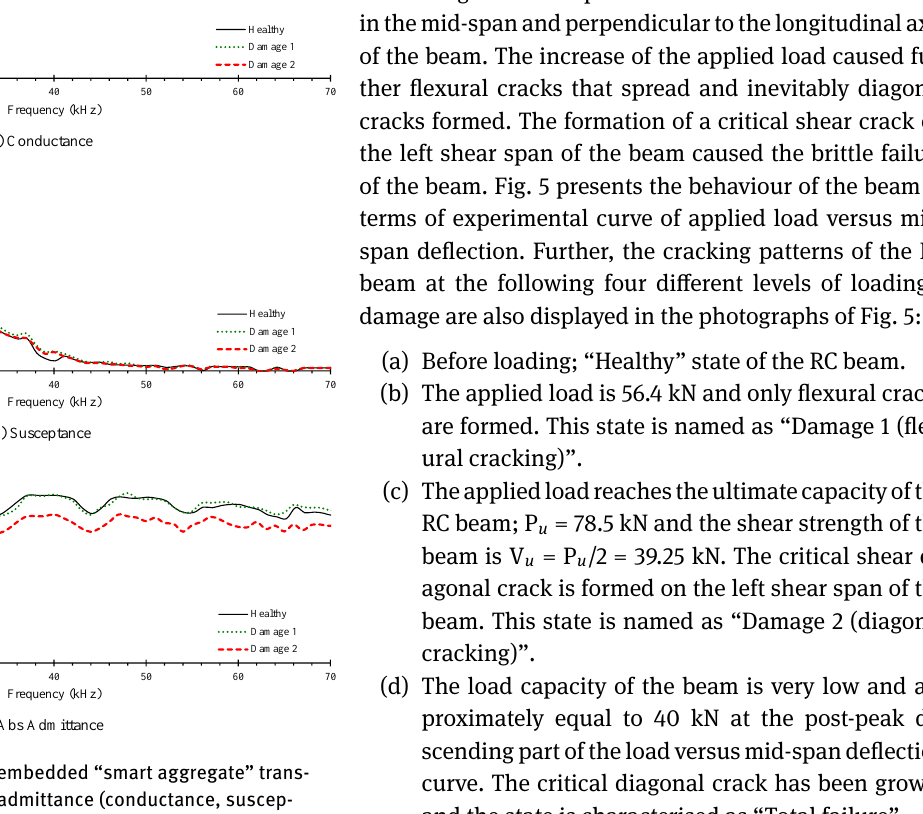
ing a pinned-end actuator and was measured by a load cell with accuracy equal to 0.05 kN. The net mid-span de- flections of the tested beam were recorded by three Linear VariableDifferentialTransducers(LVDTs)with0.01mmac- curacy. One of them was placed at the middle of the beam span and the other two at the supports, as shown in Figs. 3 and 4. Measurements for load and deflection were read and recorded continuously during the tests. Further, mea- surements of the EMA of the embedded PZT transducers inside concrete mass as “smart aggregates” and the exter- nally epoxy bonded PZTs were recorded at two different levels of the applied loading using the experimental set-up of the adopted EMA procedure shown in Fig. 1. A harmonic excitation voltage of 10 Volts is amplified to the mounted PZTs in time domain range at every central frequency, as described by the expression